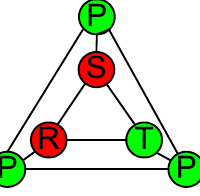
Figure 10. Evil ideology with failed R and S but working T.